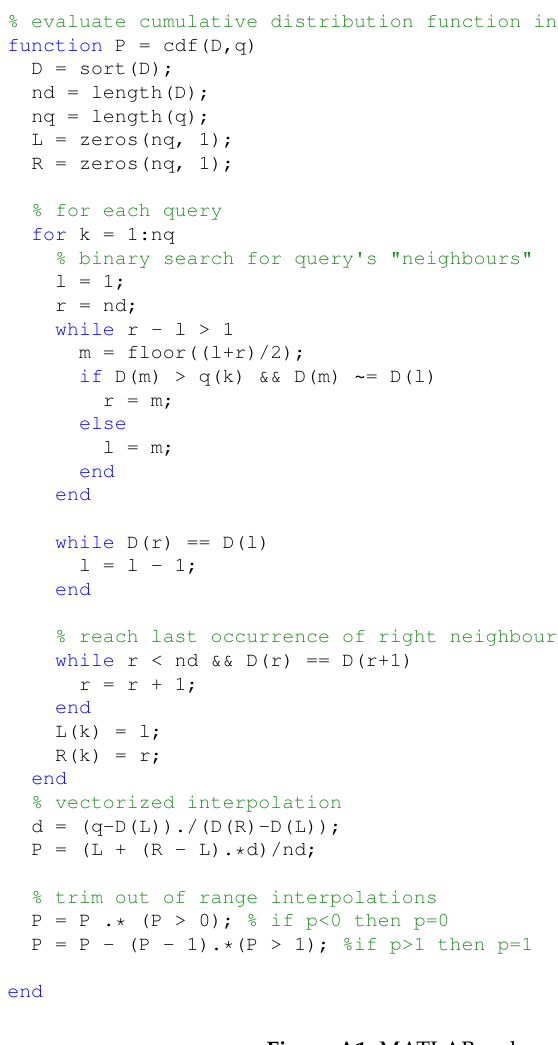
Figure A1. MATLAB code used to implement the CDF